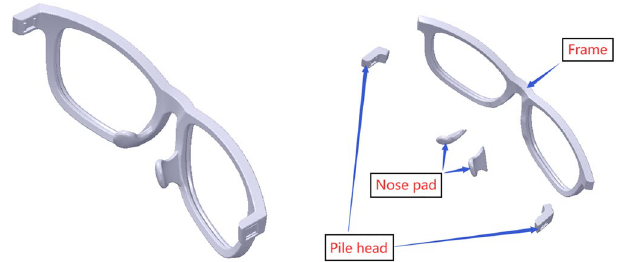
Figure 4. Glasses frame modularization. From left to right: assembly view, disassembly view.